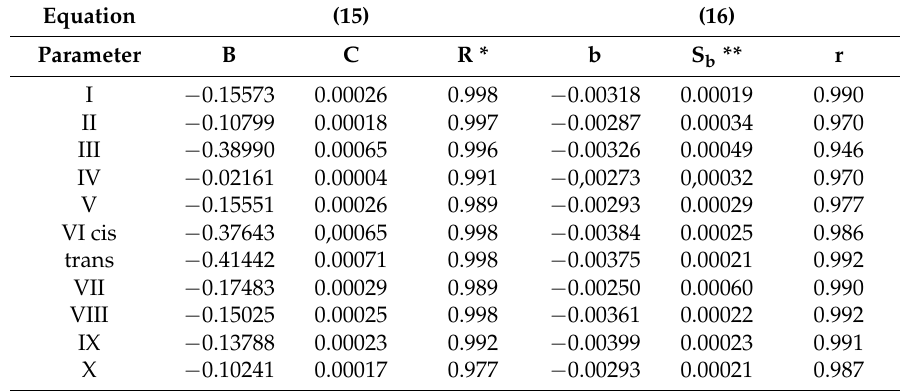
Table 7. Calculated parameters of dependence ln CMC = f( T ) – B and C (Equation 15), β = f( T ) – b (Equation 16) and correlation coefficients.